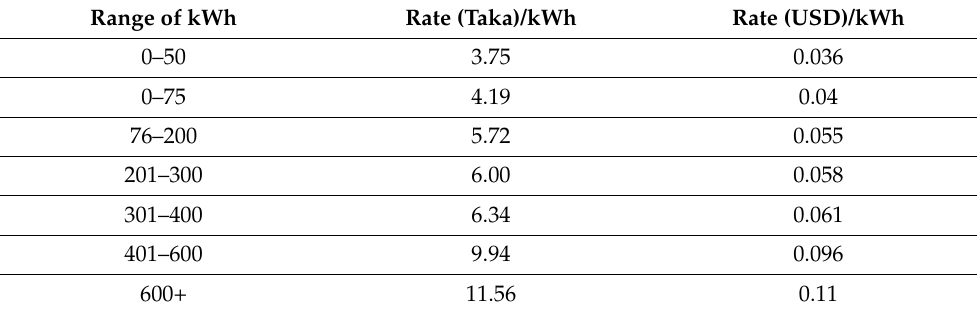
Table 1. Electric bills in residential households in Bangladesh.